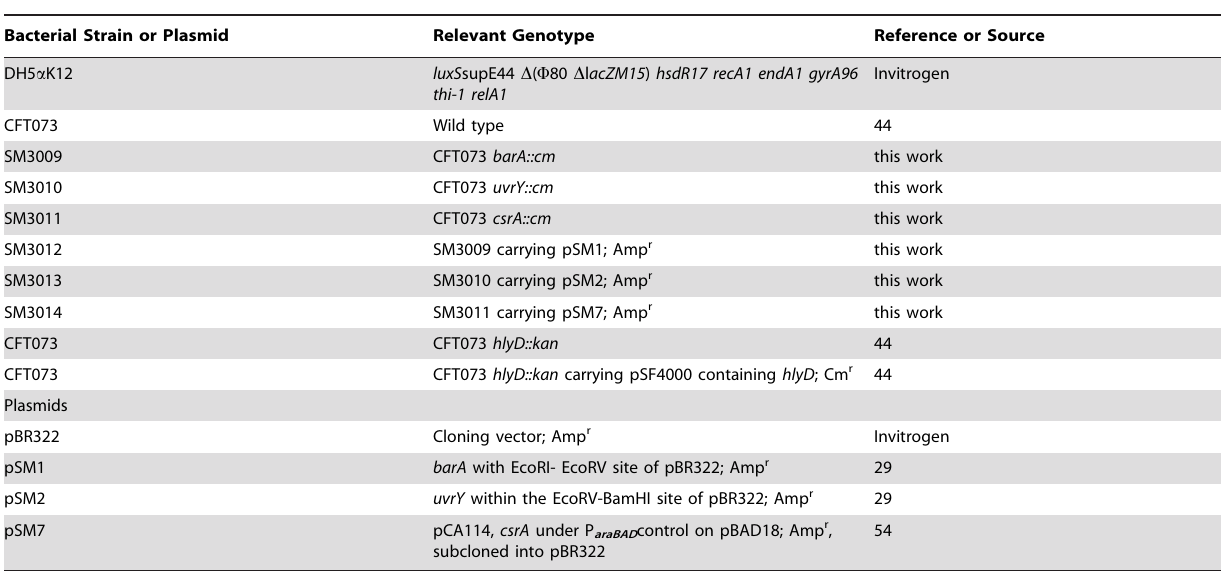
Table 2. E. coli strains and plasmids used in this study.